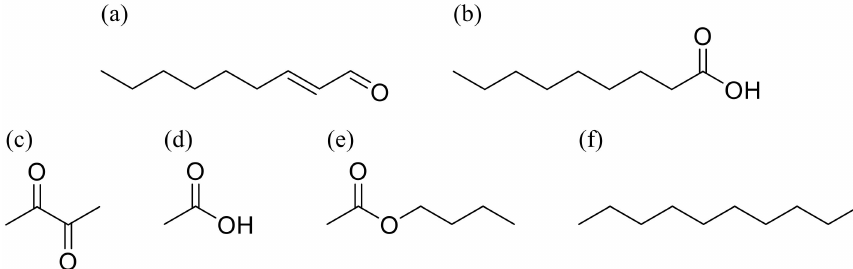
Figure 1. Structural formulas of target and contaminant gases. ( a ) trans -2-nonenal (2N); ( b ) pelargonic acid (nonanoic acid; PA), ( c ) diacetyl (2,3-butandione; DA), ( d ) acetic acid (AA), ( e ) butyl acetate (B), and ( f ) n -decane